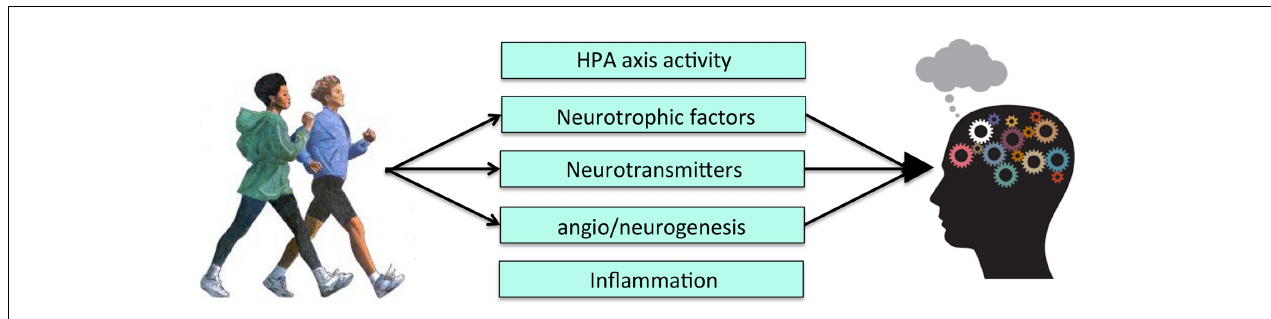
FIGURE 2 | Level 1 of analysis: Possible molecular and cellular mechanisms of PA. HPA, Hypothalamic-pituitary-adrenal axis activity.